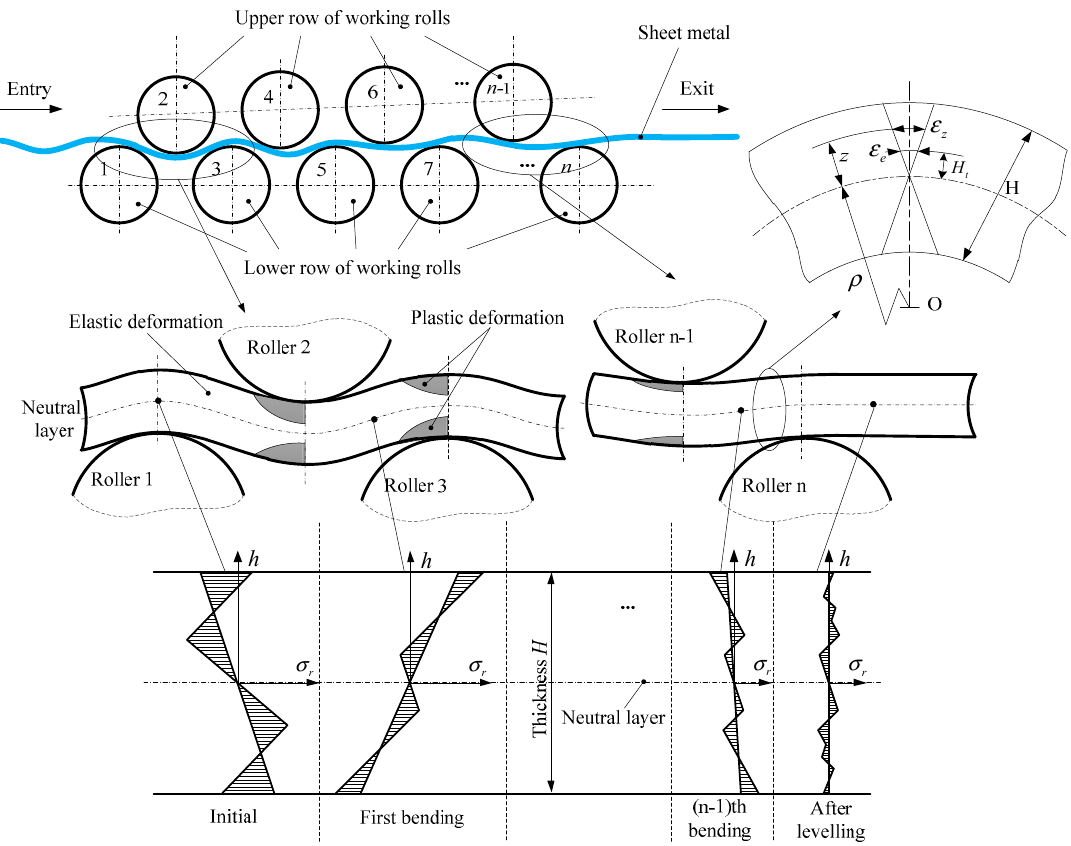
Figure 1. Variation of the residual stress in multi-roll levelling.